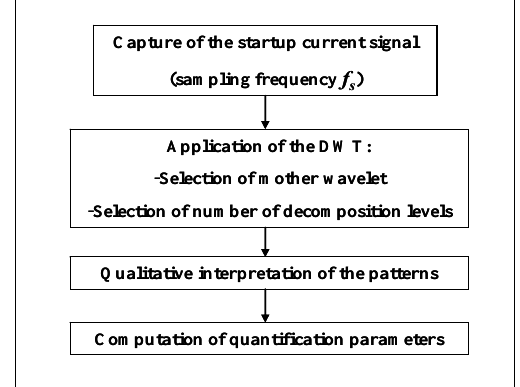
Fig. 5. Scheme for the diagnosis